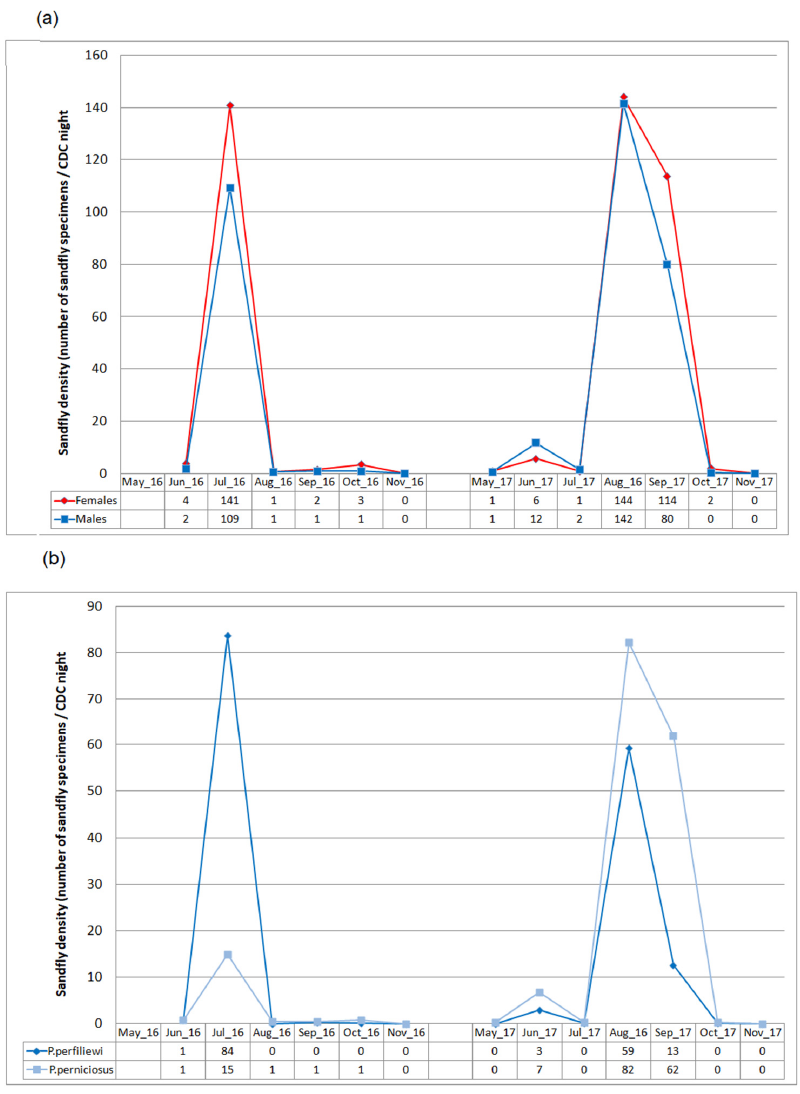
Figure 4. Seasonal density pattern of sandflies during the two-year period. ( a ) Density patterns of male and female sandflies. ( b ) Density pattern of P. perniciosus and P. perfiliewi male specimens.